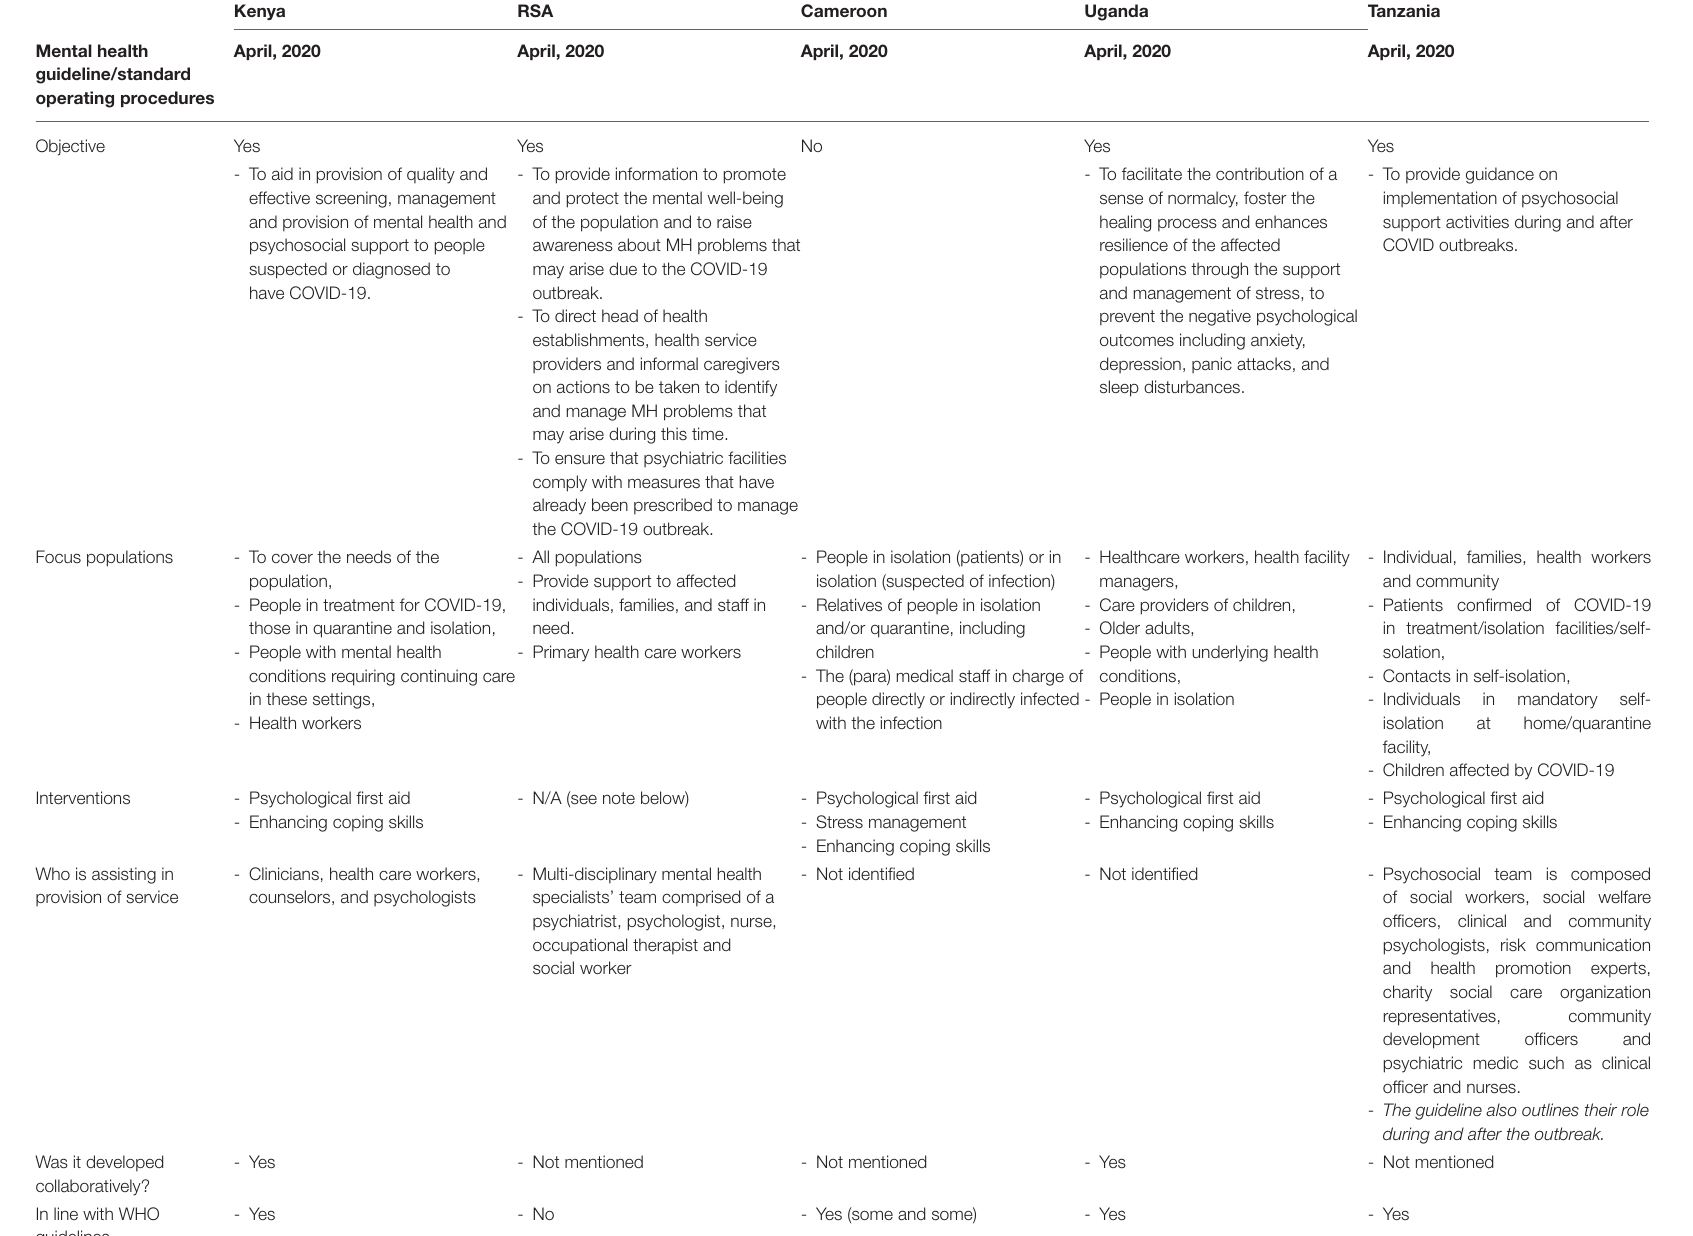
TABLE 2 | Summary of guidelines and SOP’s of MH and PSS during the COVID-19 outbreak in South Africa, Kenya, Uganda, Tanzania, Cameroon between March and April